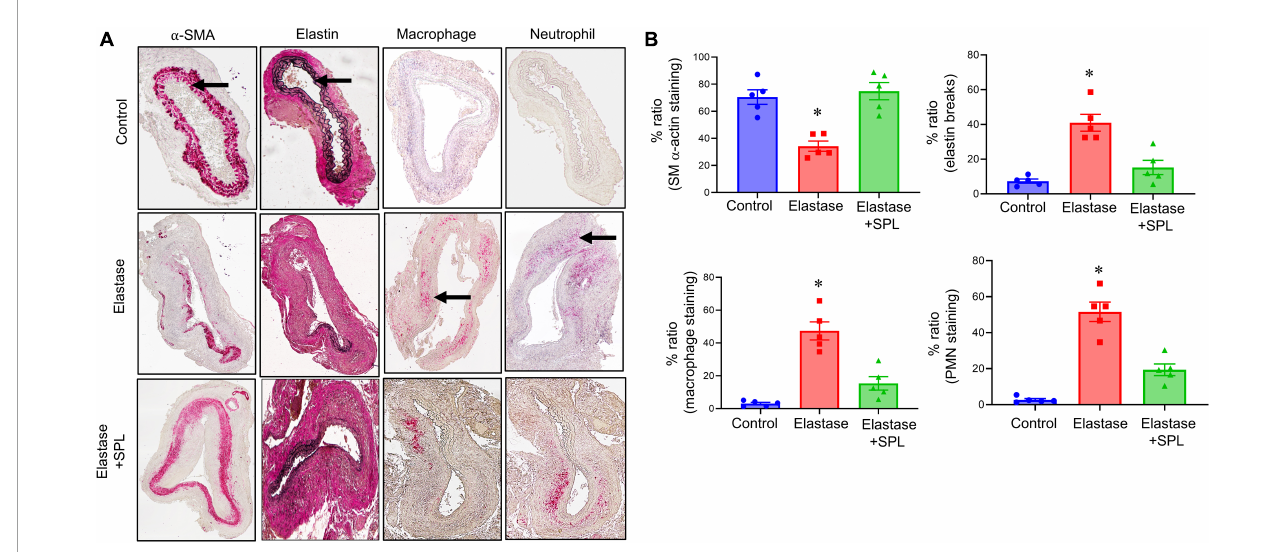
FIGURE2 Spironolactone treatment protects the aortic morphology during AAA formation. (A) Comparative histology displayed a marked increase in SM α -actin expression, as well as decrease in elastin fiber disruption (VVG staining) and leukocyte (macrophage and PMN) infiltration in SPL-treated mice compared to untreated mice. Arrows indicate areas of immunostaining. n = 5/group. (B) Quantification of immunohistochemical staining demonstrates a significant increase in SM α -actin expression, decrease in elastin degradation, and leukocyte infiltration in SPL-treated aortic tissue compared to elastase-treated mice alone. ∗ P < 0.01 vs. other groups.